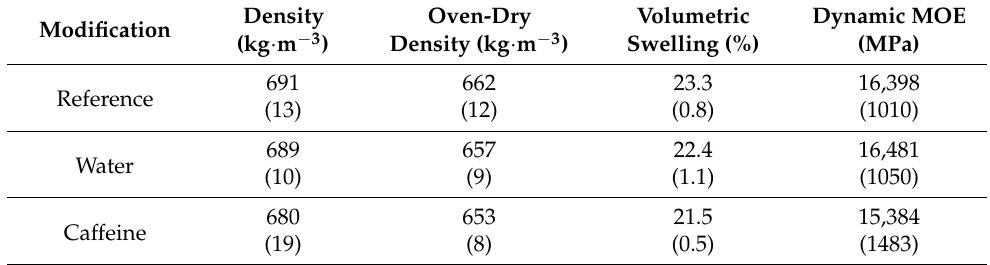
Table 3. Basic statistical analyses, mean value (standard deviation) of the selected properties for beech wood.